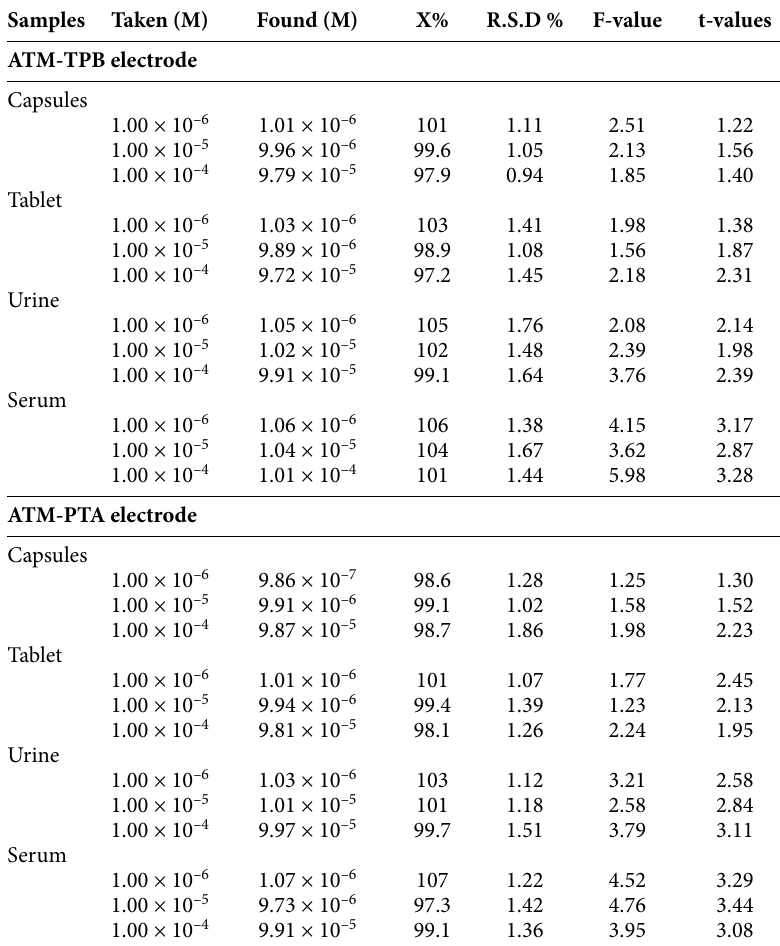
Table 3: Recovery of atomoxetine hydrochloride from pharmaceutical preparations and spiked biological fluids samples by ATM-TPB and ATM-PTA electrodes. Samples Taken (M) Found